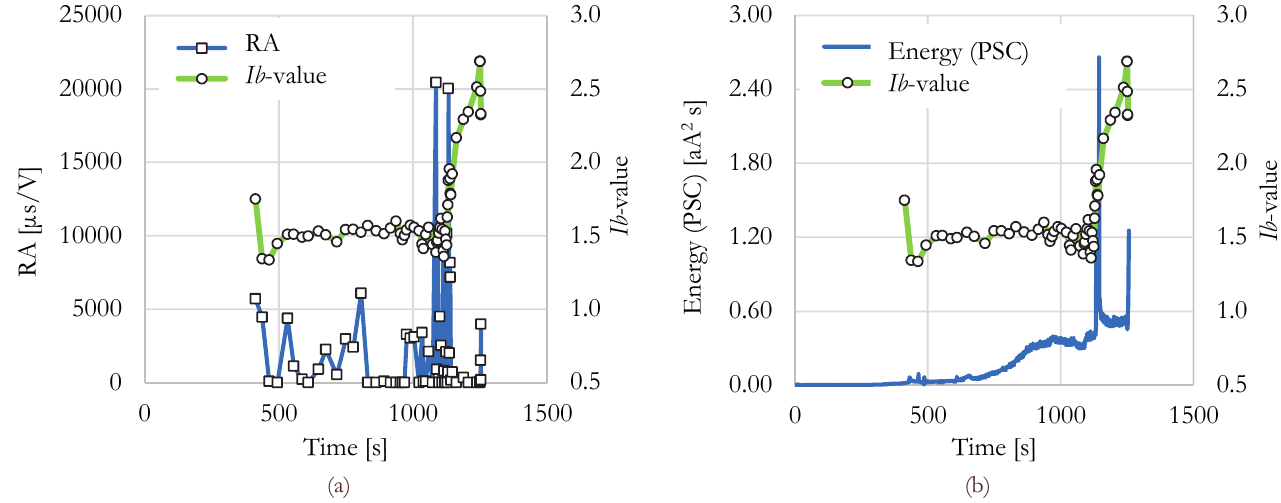
Figure 11: Time variation of the Ib -value in juxtaposition to the respective variation of (a) the RA parameter and (b) PSC